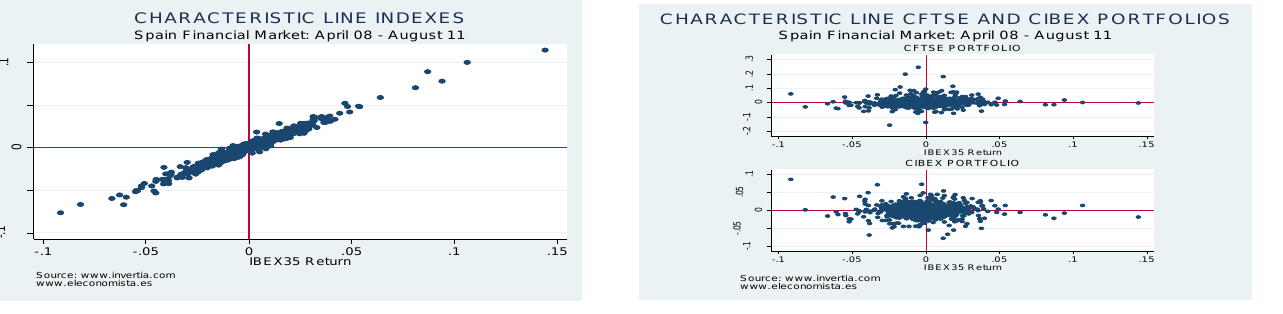
Figure 2: Characteristic line for the IBEX35 and FTSE4Good